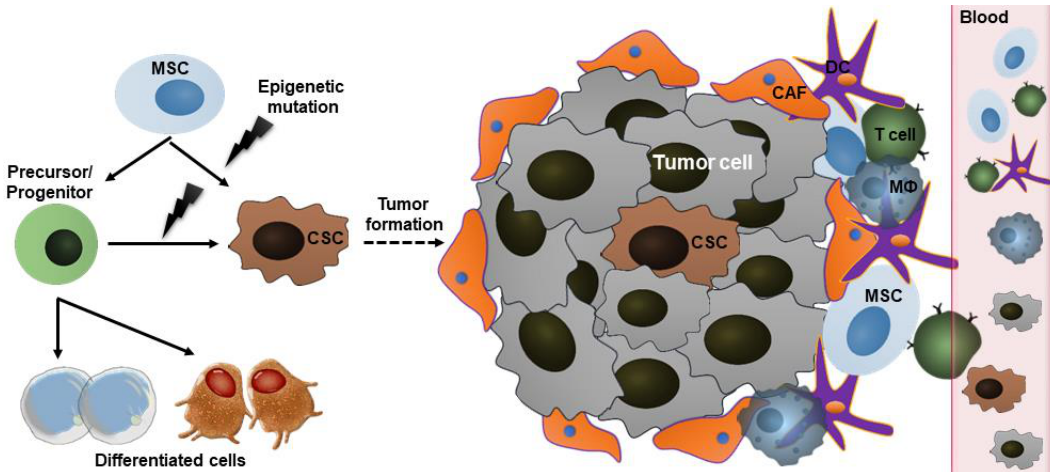
Figure 1. Tumor formation and its complex microenvironment. Epigenetic mutations in normal stem cells or precursor / progenitor cells lead to generation of CSCs, which play crucial roles in tumor stemness, initiation, maintenance, and metastasis. Tumor niche contains not only tumor cells and CSCs but also cancer-associated immune cells (T-cells, macrophages (M Φ ), dendritic cells (DC)), cancer-associated fibroblasts (CAF), and other cells. In addition, MSCs are recruited to tumor by chemoattractant factors secreted from all those cells (CXCL16, SDF-1, CCL-25, and IL-6, TNF- α , and IL-1 β ), playing crucial roles in tumor